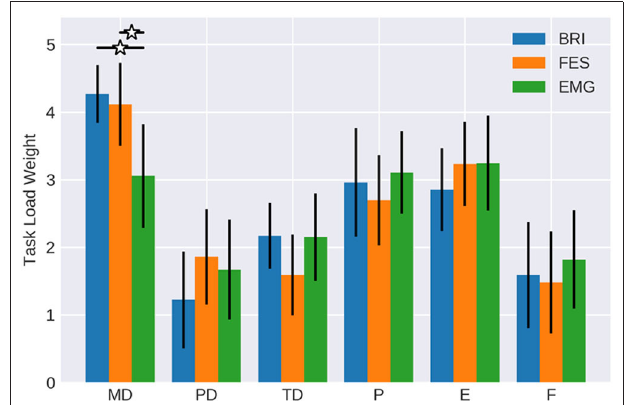
FIGURE 3 | Weights of workload categories. The work load categories mental demand (MD), physical demand (PD), temporal demand (TD), performance (P), effort (E) and frustration (F) of the NASA-TLX for BMI control of passive movement with different feedback modalities (Robotic vs. FES) in comparison to active movement with EMG feedback (data form Fels et al., 2015). Confidence intervals are given with a probability of